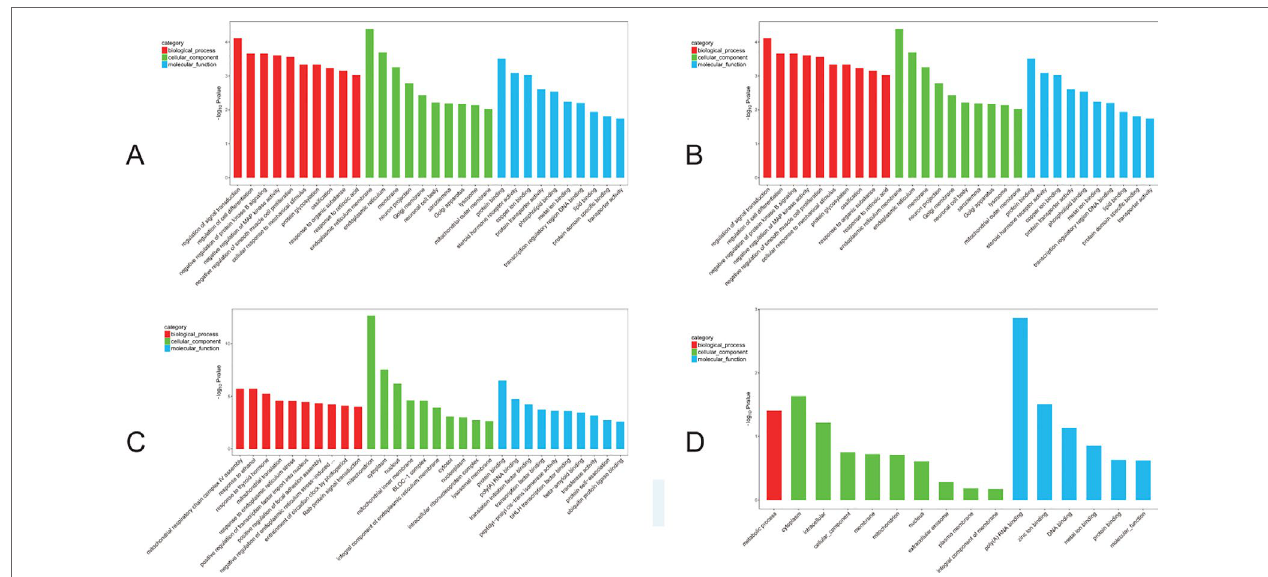
FIGURE 6 | GO analyses of DEGs. The red bar: biological process; the green bar: cellular component; the blue bar: molecular function. (A) The GO analysis of the top 10 F1 up-regulated DEGs. (B) The GO analysis of the top 10 F1 down-regulated DEGs. (C) The GO analysis of the top 10 F2 up-regulated DEGs. (D) The GO analysis of the top 10 F2 down-regulated